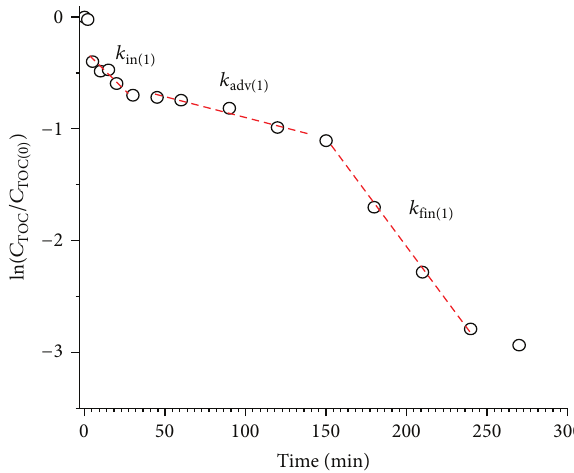
Figure 6: Plots of ln (𝐶 TOC /𝐶 TOC ( 0 ) ) versus reaction time calculated fromtheexperimentalTOCversustimecurvesofDCFphotominer- alization in the presence of TiO 2 nanocrystals, according to (6) and